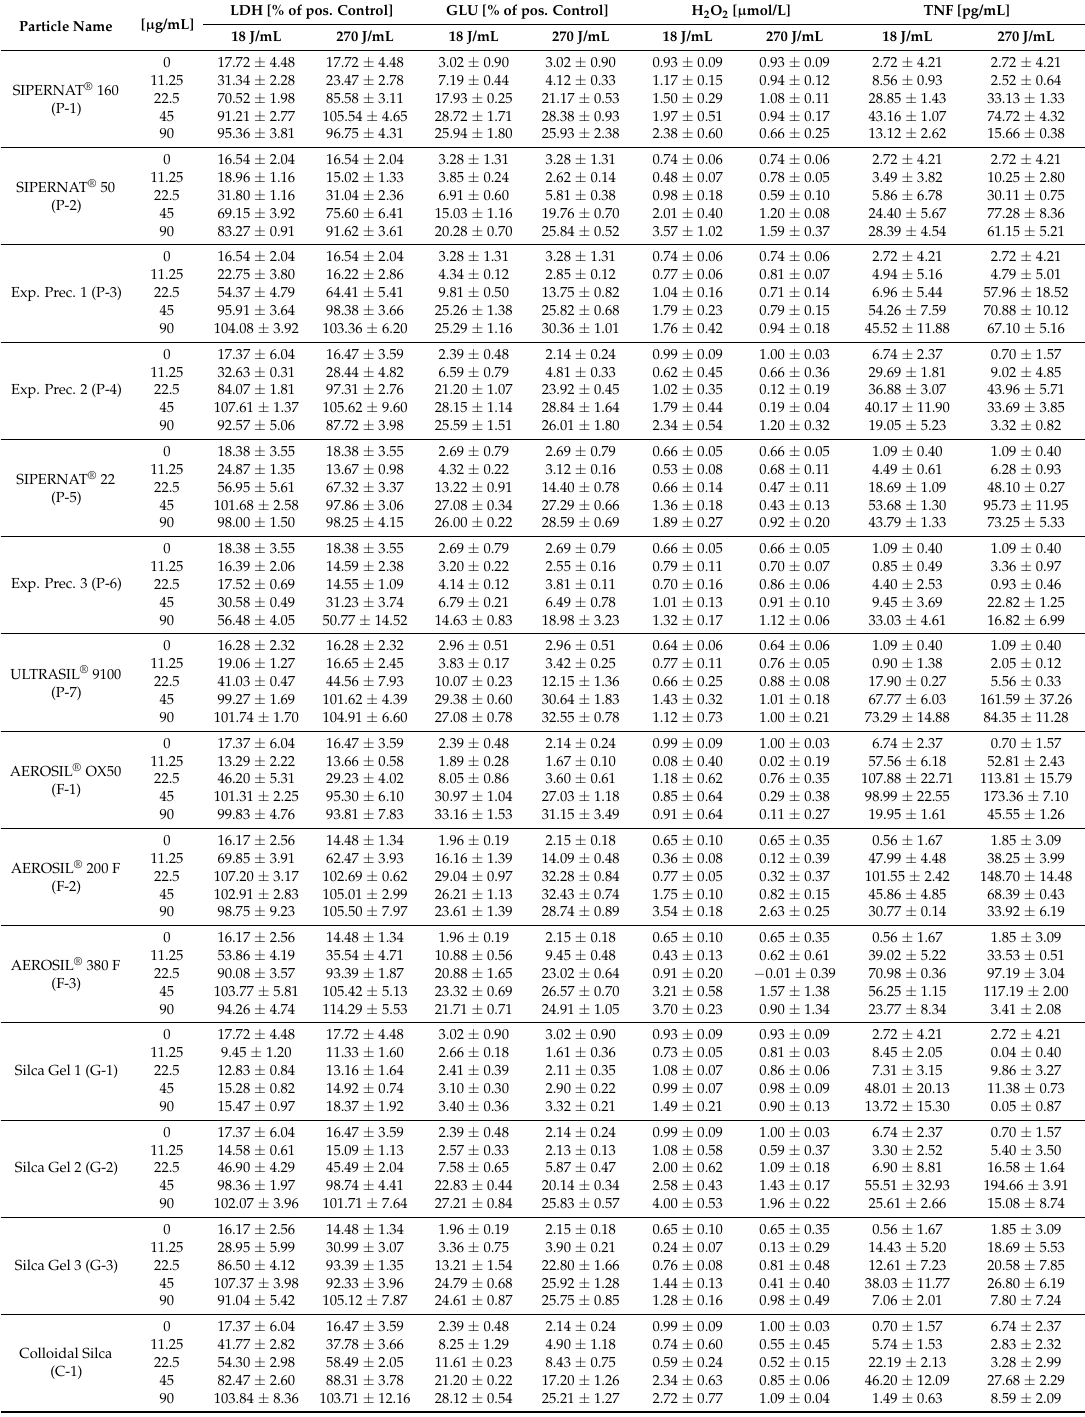
Table 2. Values from in vitro tests with the alveolar macrophage